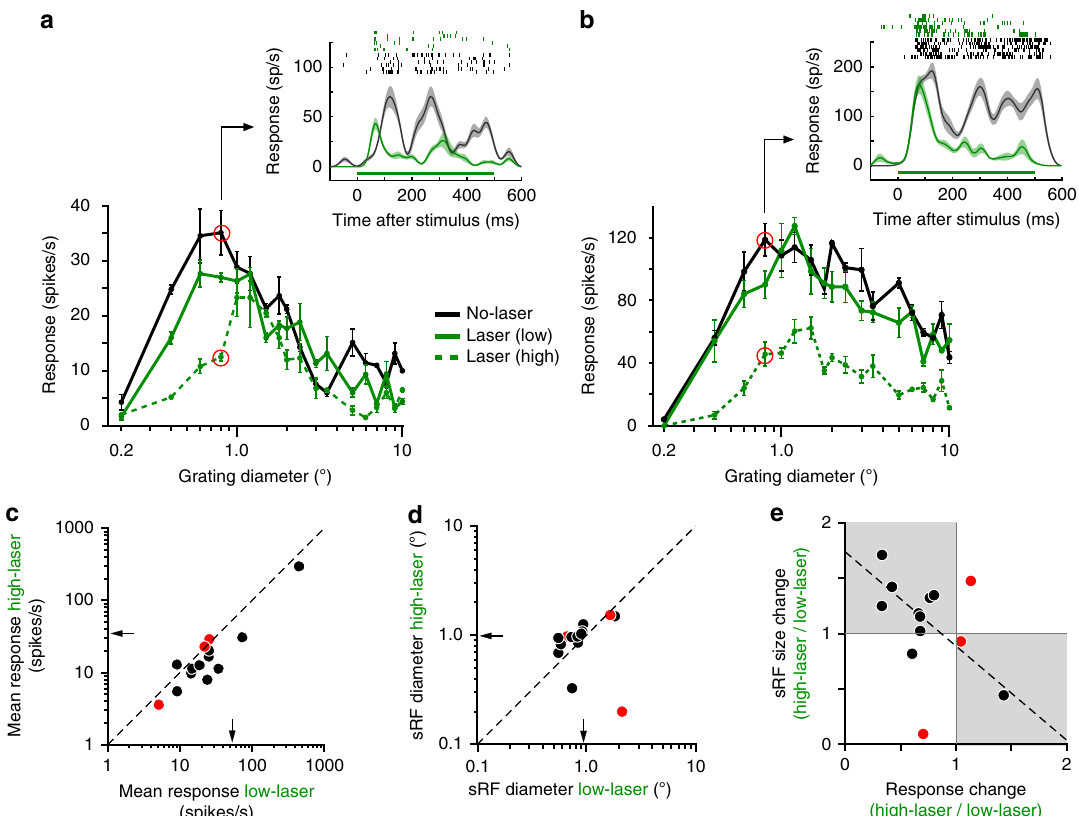
Fig. 4 Feedback controls the amplitude of V1 responses. a , b Spatial-summation curves for two example V1 cells measured without laser (black) and with (green) laser stimulation at two different intensities (solid green: 9 mW/mm 2 ; dashed green 43 mW/mm 2 ). Other conventions are as in Fig. 2a. c Response amplitude (here de fi ned as mean response over the entire spatial summation curve) for each cell at low and high laser intensity ( n = 14). d sRF diameter for each cell at low and high laser intensity. Black and red dots in c – e indicate cells showing signi fi cant ( T -test, p < 0.05) and non-signi fi cant change in response amplitude, respectively. Arrows in c – d : means. Dashed line in c – d : unity line. e sRF size change (ratio of diameter at low to high laser) vs. response change (ratio of response amplitude at low to high laser). Shaded area indicates cells for which sRF size increased and response amplitude decreased with increasing laser intensity (and vice versa). Dashed line: regression